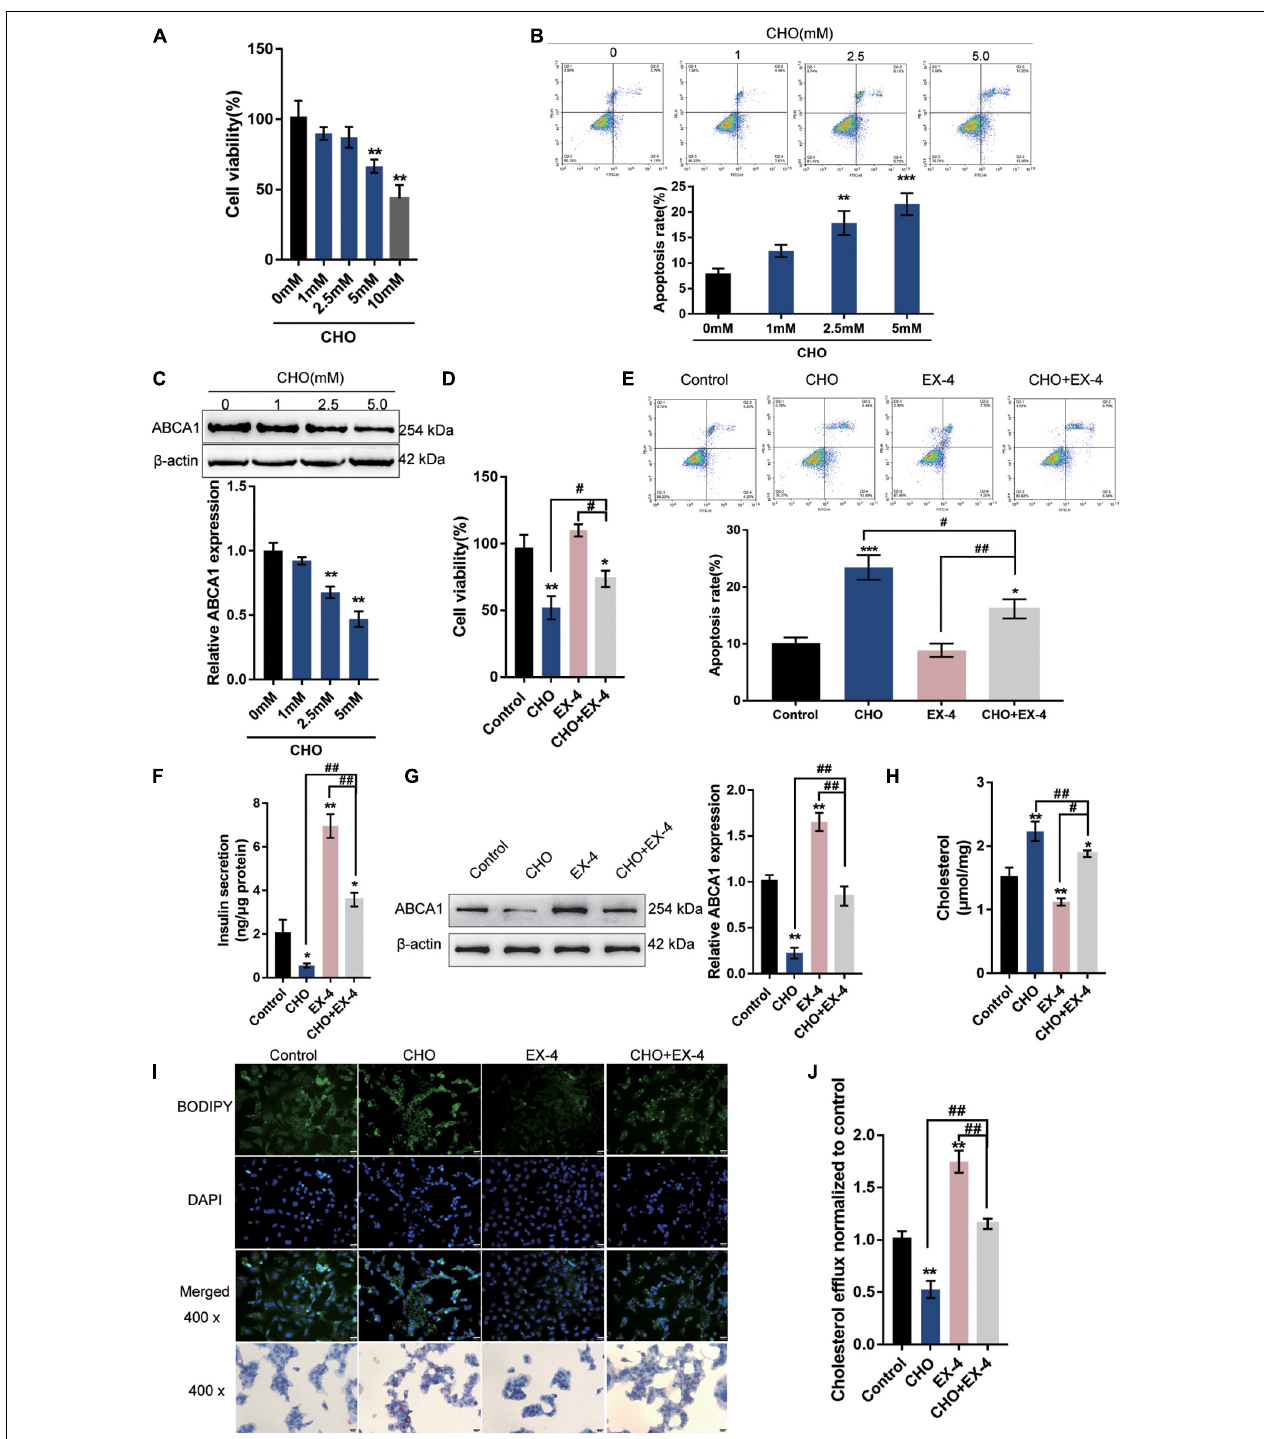
FIGURE 1 | GLP-1 downregulates ABCA1 expression and cholesterol accumulation-induced toxicity in INS-1 cells. INS-1 cells were cultured in a medium containing a series of concentrations of cholesterol (0, 1, 2.5, 5, or 10 mM) for 24 h and examined for (A) cell viability by MTT assay; (B) cell apoptosis by Flow cytometry; (C) the protein levels of ABCA1 by Immunoblotting. Next, INS-1 cells were cultured in a medium containing 0 or 5 mM cholesterol in the presence or absence of 10 nM Exendin-4 (EX-4) for 24 h and examined for (D) cell viability by MTT assay; (E) cell apoptosis by Flow cytometry; (F) insulin secretion by insulin ELISA kit; (G) the protein levels of ABCA1 by Immunoblotting; (H) intracellular cholesterol concentration using cholesterol assay kits; (I) intracellular lipid deposition by Oil Red O and BODIPY staining. (J) The cholesterol efflux from INS-1 cells by BODIPY-cholesterol assay; n = 3 for each experiment. * P < 0.05, ** P < 0.01, *** P < 0.005, compared with control group, # P < 0.05, ## P < 0.01, compared with CHO + EX-4 group.